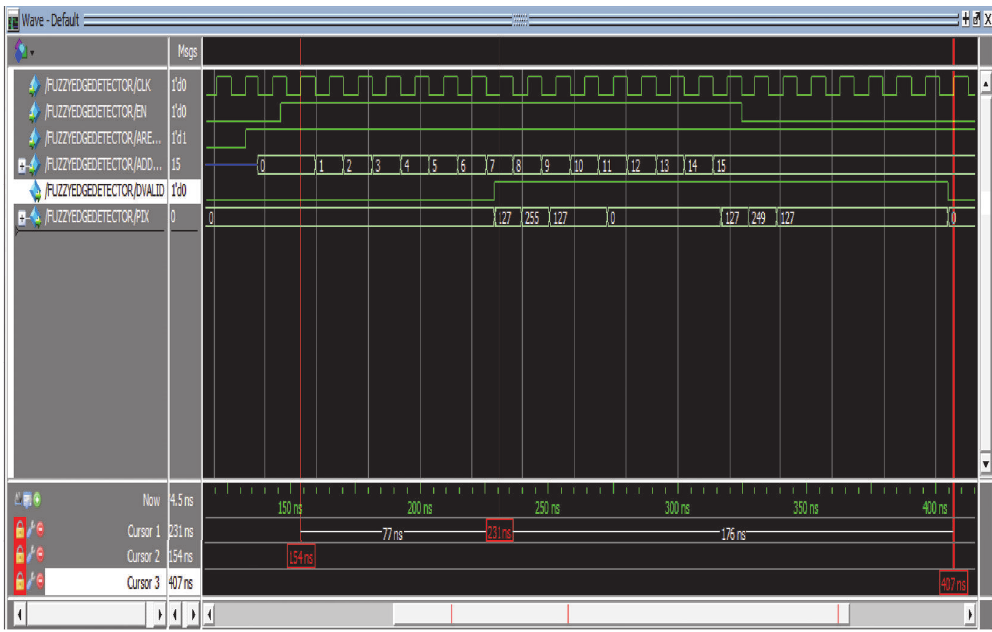
Figure 10: System simulation on Artix-7 Xc7a100tcsg324-2.